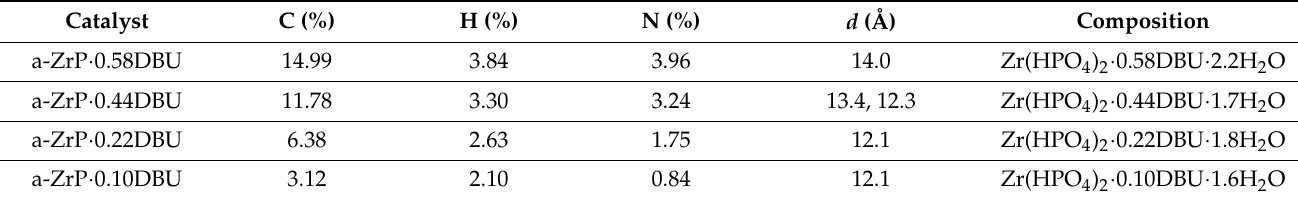
Table 1. Composition determined by elemental analysis and basal